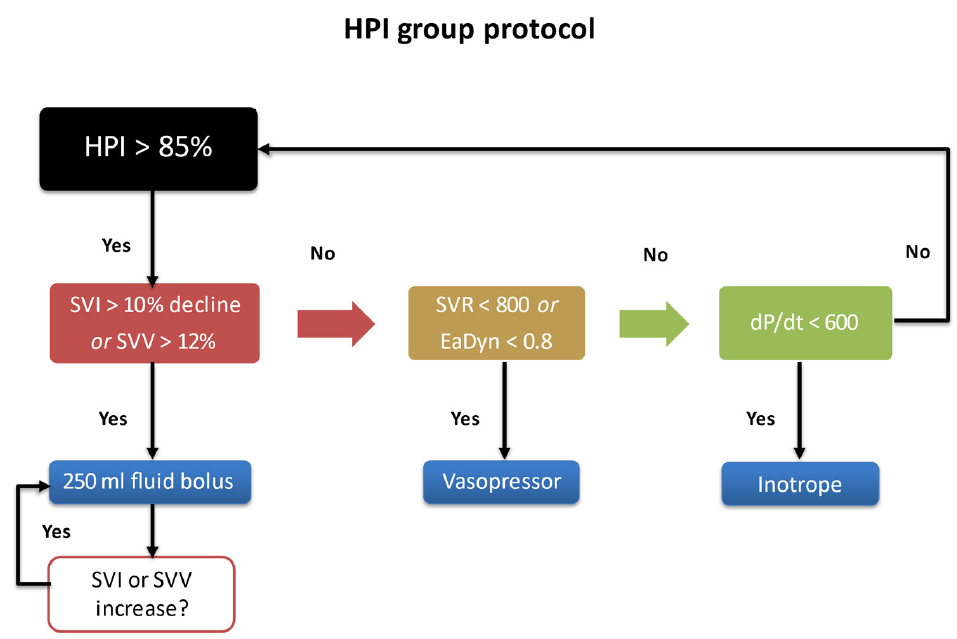
Figure 1. Goal directed hemodynamic protocol.